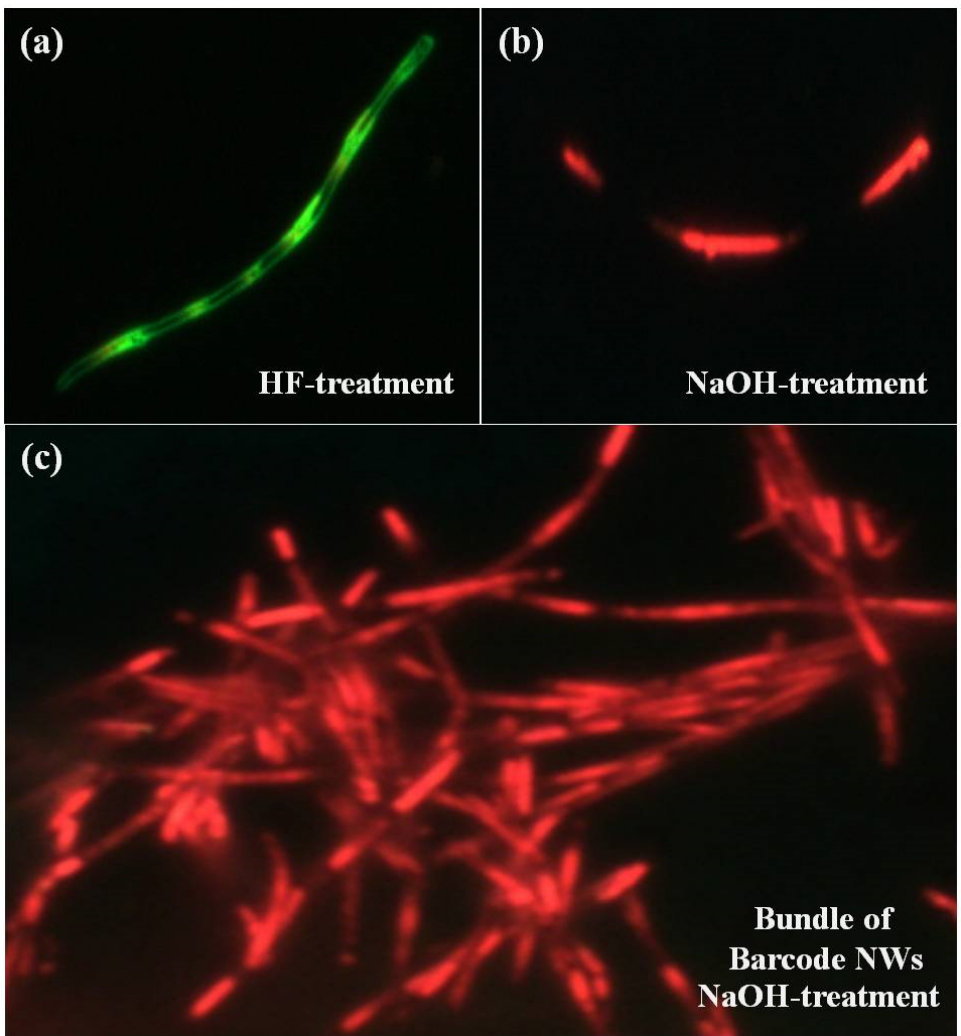
Figure 4. Luminescence CCD images of a single unit of: ( a ) HF-treated barcode NW; ( b ) NaOH-treated barcode NW; and ( c ) bundle of NaOH-treated barcode NW. barcode NW; and ( c ) bundle of NaOH-treated barcode